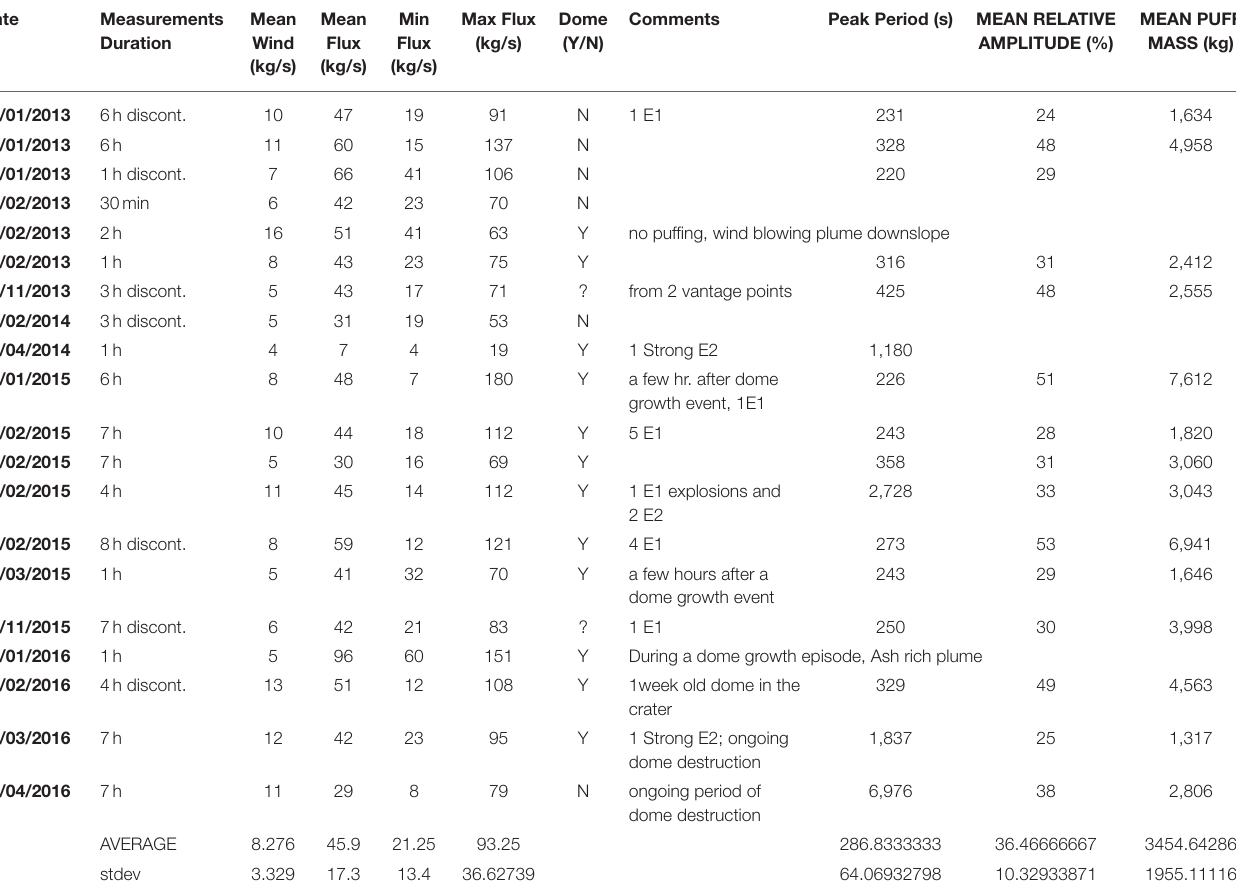
TABLE 1 | summary of the SO 2 flux data set obtained at